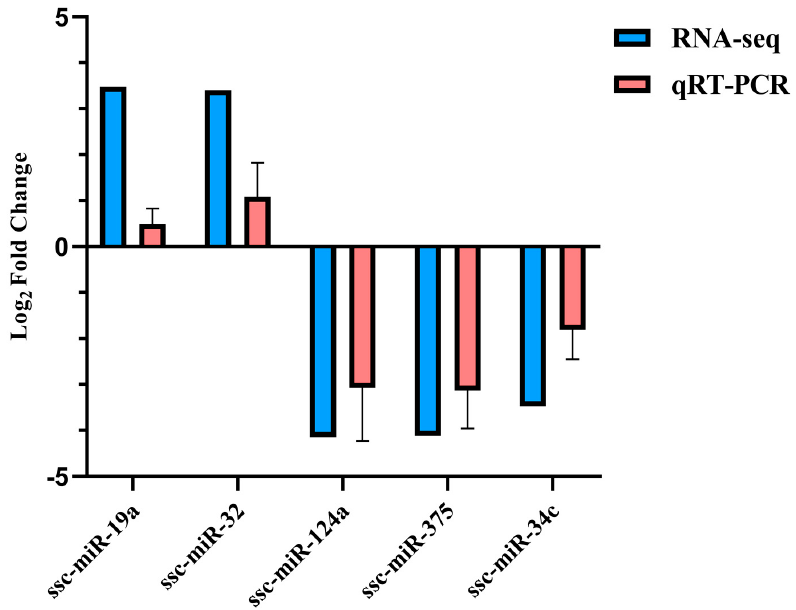
Figure 8. Five DE miRNAs validated by